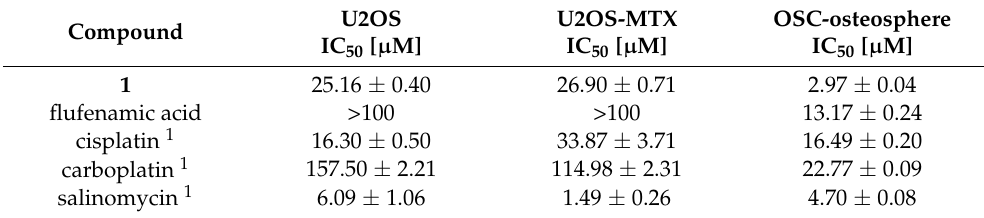
Table 1. IC 50 values of 1 , flufenamic acid, cisplatin, carboplatin and salinomycin against U2OS and U2OS-MTX cells and U2OS-MTX osteospheres determined after three or 10 days incubation (mean of two or three independent experiments ± SD).